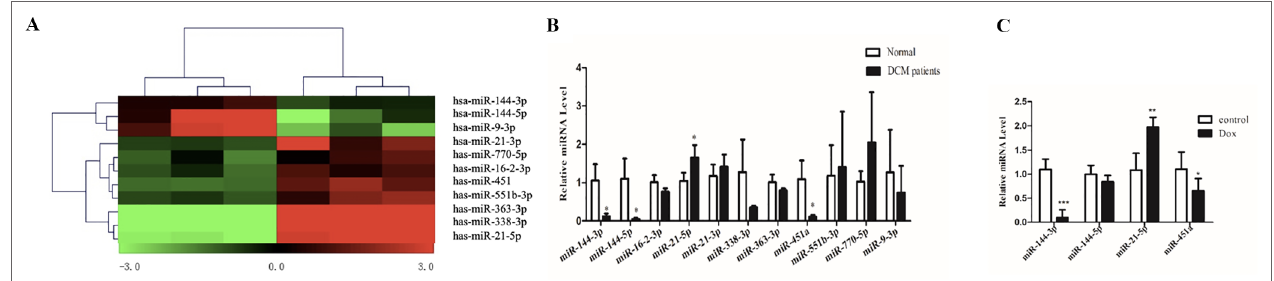
FIgURE 2 | MiRNA array using heart samples from DCM patients and healthy controls. (A) . Heatmap of miRNA array between DCM patients and healthy controls and a total of 11 miRNAs were found to be dysregulated. (B) . qRT-PCR analysis of miRNA between DCM patients and healthy controls (n = 3). (C) . qRT-PCR analysis of miRNA between doxorubicin-induced DCM models and controls (n = 6). *, p < 0.05; **, p < 0.01; ***, p < 0.001.